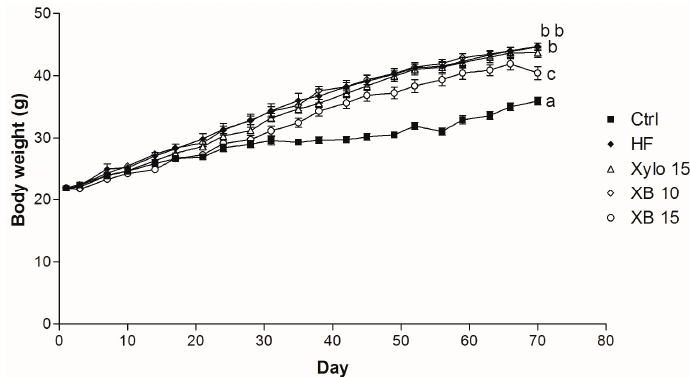
Figure 1. Effect of XB on body weight (b.w.) changes. b.w. of the five experimental groups are